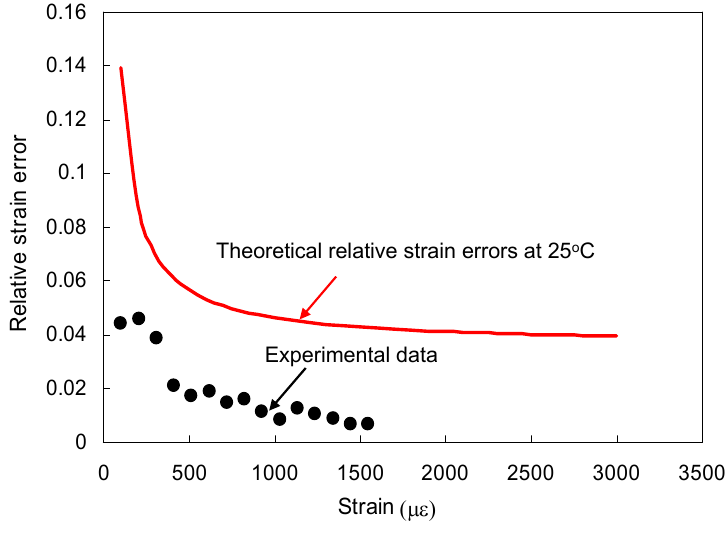
Figure 7. Measured and calculated relative strain error as a function of strain. In error analysis, all measurement errors are taken into